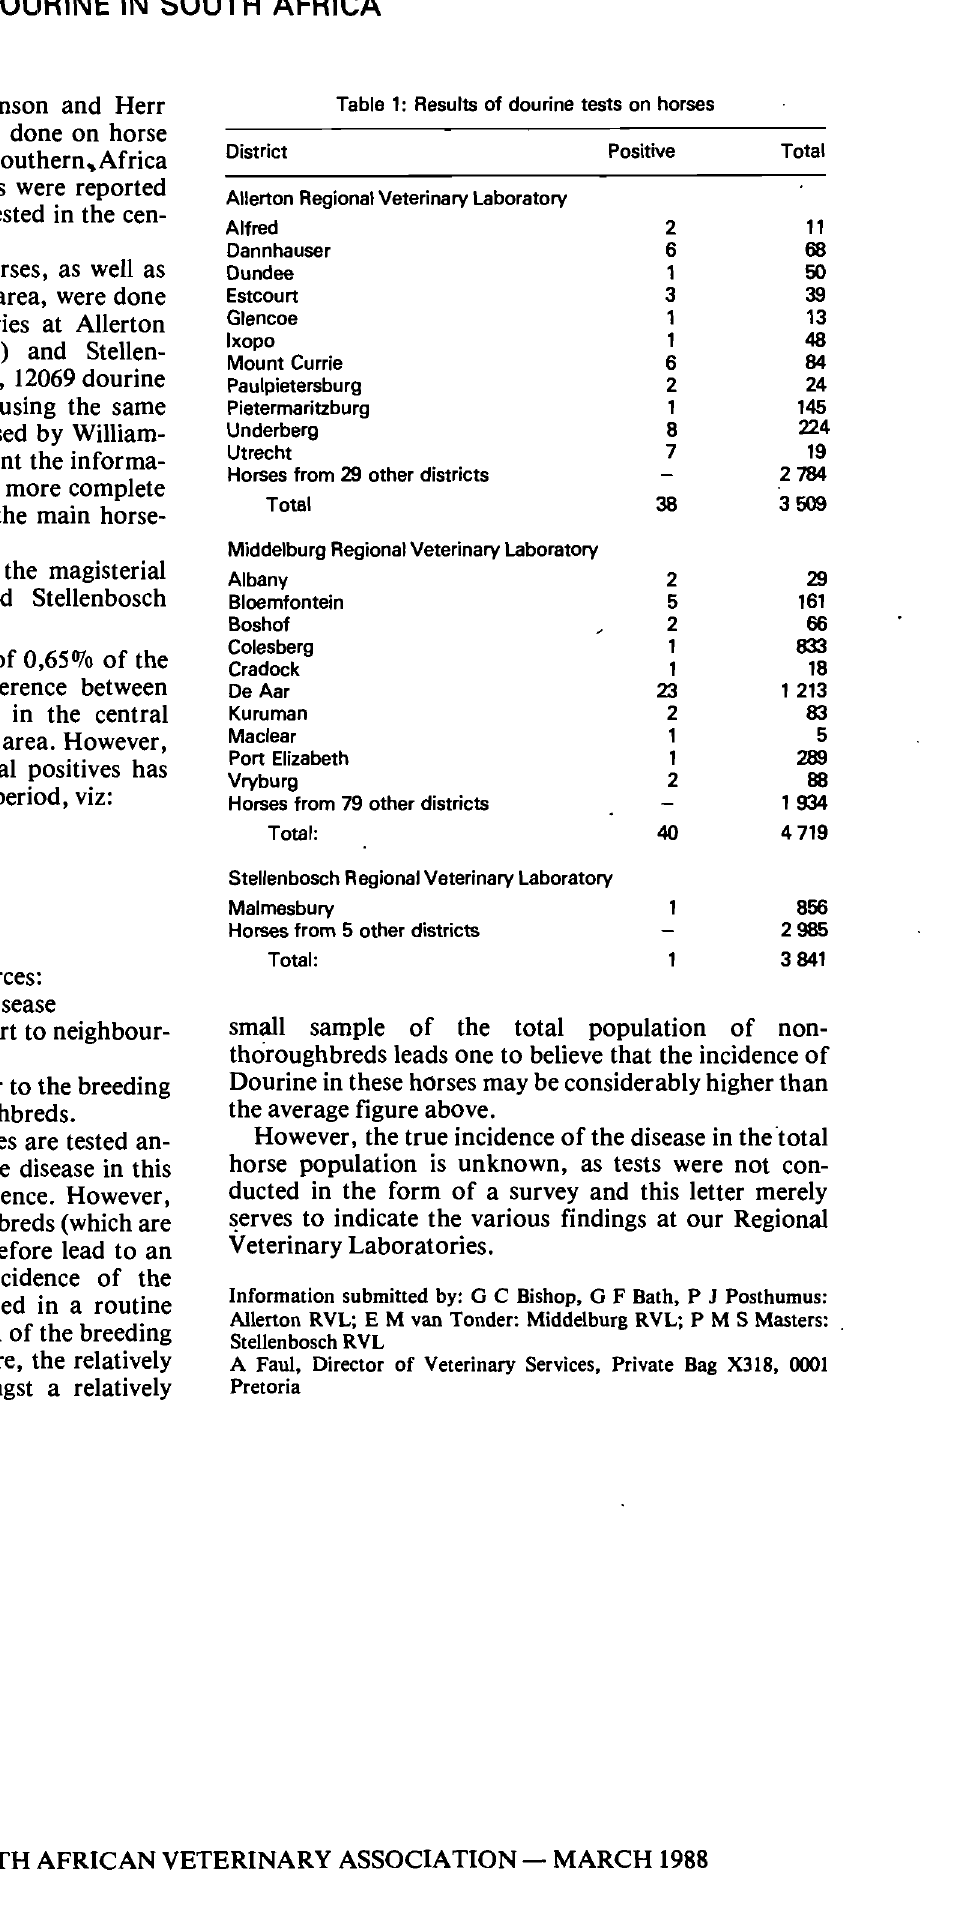
Table 1: Results of dourine tests on